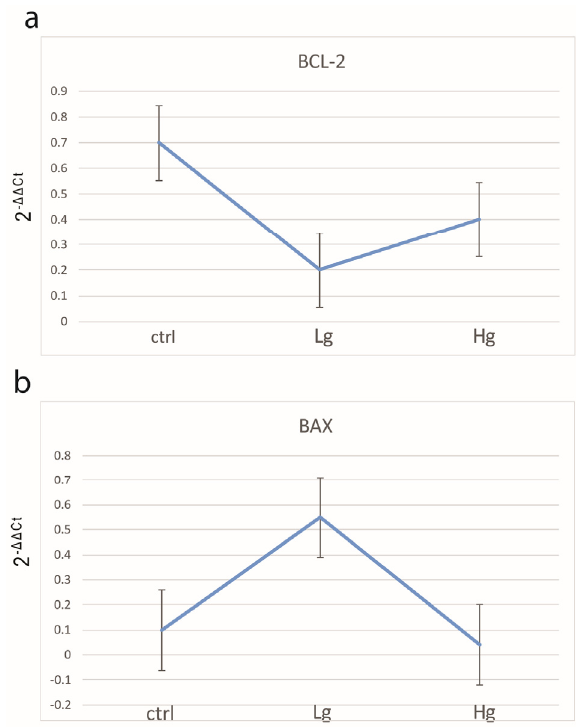
Figure 4. The qRT-PCR analysis of colorectal samples and controls using primers for BAX and BCL2 and their calculated 2 −ΔΔ Ct . Number of samples analyzed were 5 samples per group. Control colon tissue (ctrl), low-grade colon cancer (Lg), and high-grade colon cancer